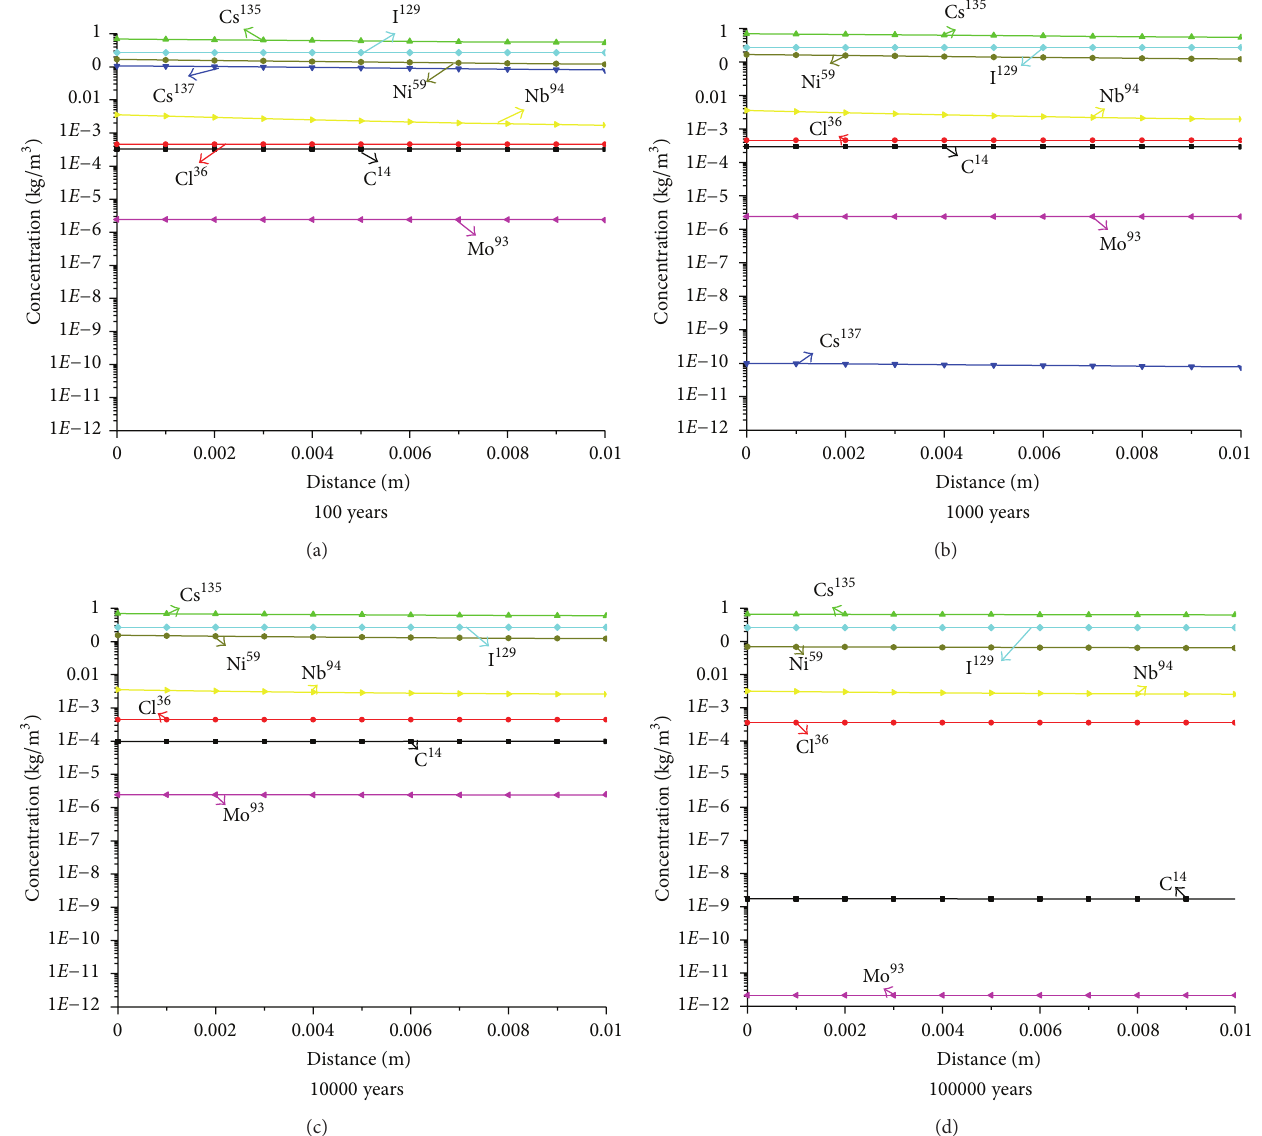
Figure 5: Concentration profiles in extruded bentonite region for 10 2 , 10 3 , 10 4 , and 10 5 years.